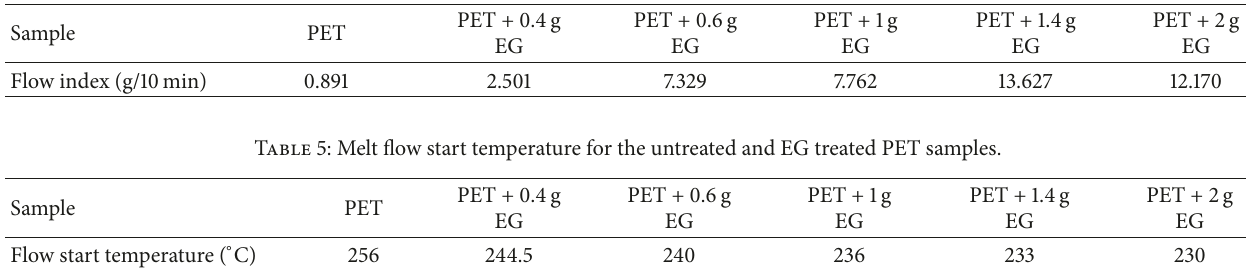
Table 4: Flow index results for untreated and EG treated PET samples.